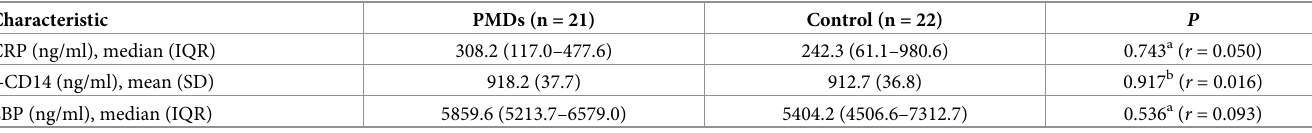
Table 2. Comparison of the endotoxin biomarkers present in the PMDs group and the control group. Characteristic